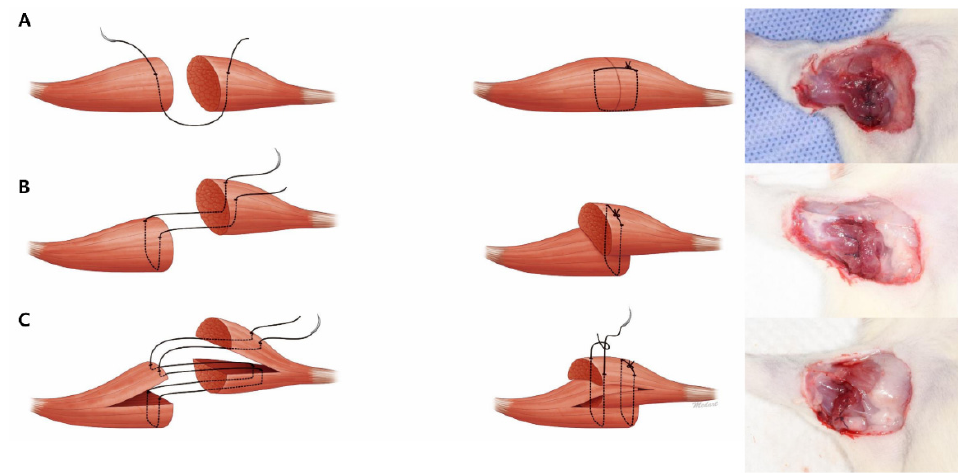
Figure 1. Muscle suture techniques. ( A ) Simple interrupted sutures. ( B ) Overlapping sutures. ( C ) Splitting-interdigitating sutures.